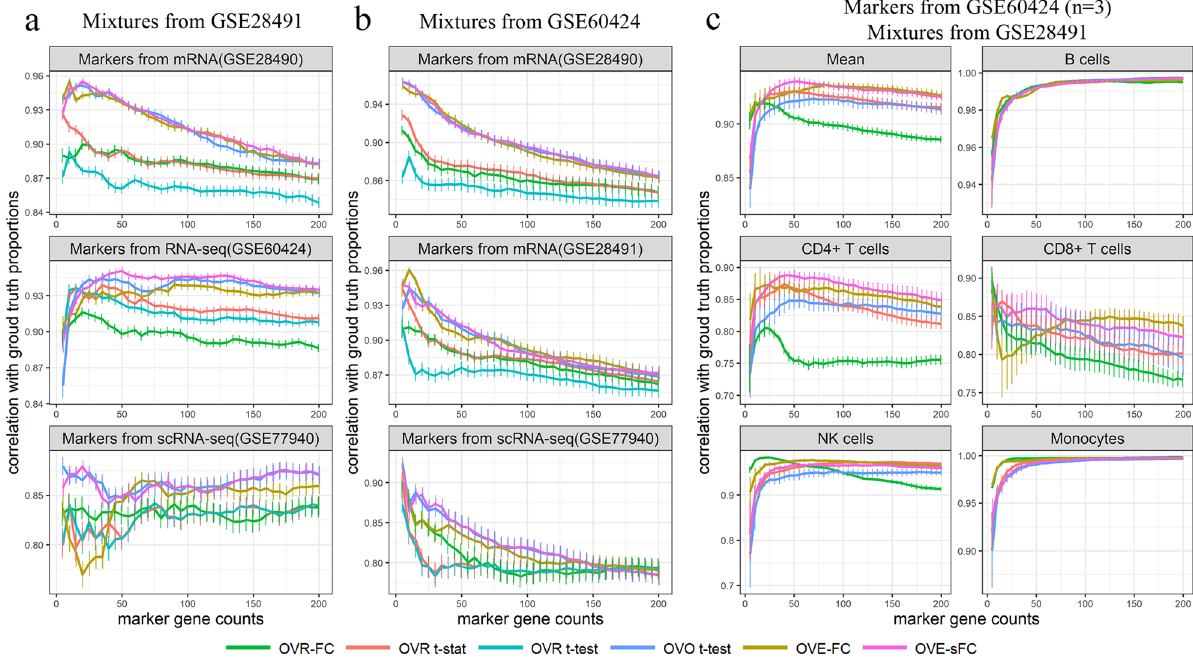
Figure 6. Correlation coefficients between CAM scores and ground truth proportions in simulated heterogeneous samples of mixed subtype mRNA expression profiles or RNAseq counts ( a – c based on three different real gene expression datasets). CAM scores are estimated using the detected SDEGs from independent dataset and reflect the proportions of subtypes (Supplementary Information). The mean and 95% confidence interval are computed over 20 repeated experiments (OVR t-test results are not shown in ( c ) due to very poor